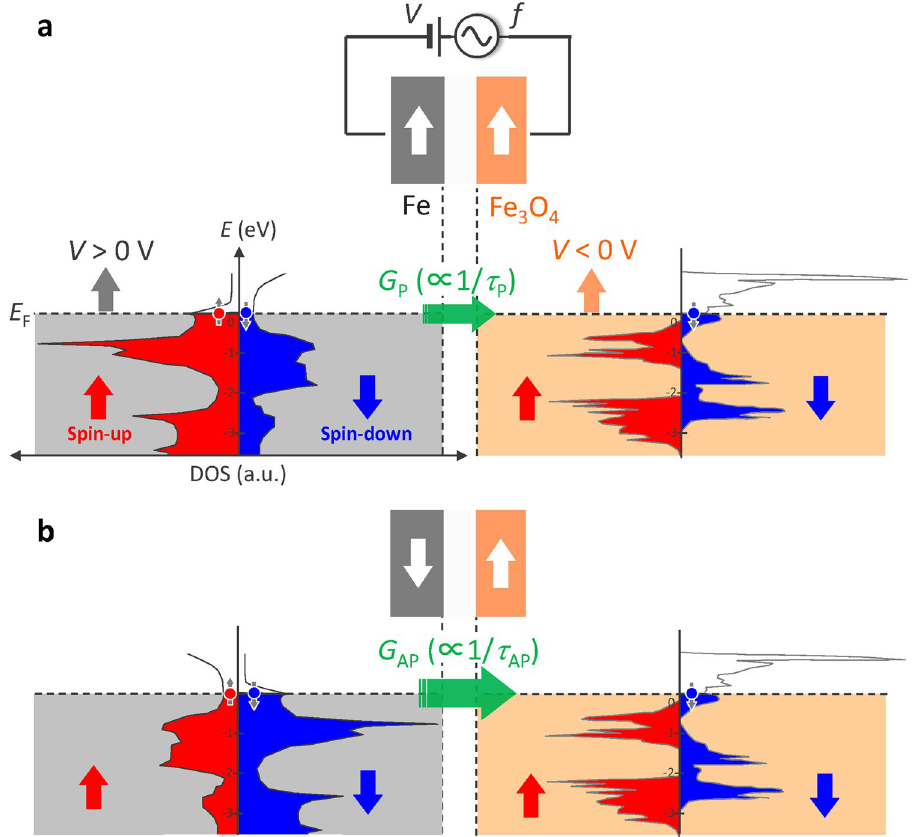
Figure 5. Band diagram of Fe and Fe 3 O 4 . ( a ) P and ( b ) AP configurations. The DOS of Fe is calculated by tight- binding linear muffin-tin orbital in the atomic sphere approximation (TB-LMTO-ASA) method and that of Fe 3 O 4 is obtained from ref. 28. The Fermi level E F is at 0 eV. The DOS in the left and right sides represents the energy band of spin-up (red) and spin-down (blue) electrons, respectively. The E F of Fe (gray panel) goes up for V > 0 V and that of Fe 3 O 4 (orange panel) goes up for V < 0 V, relatively to each other. The band calculation suggests that the conductance G AP is larger than G P , in other words, the relaxation time τ AP is shorter than τ P , indicating the appearance of inverse TMC. This inverse TMC is strongly dependent on the bias voltage V and its behavior is changed by the polarity of V . The mechanism is discussed in the main